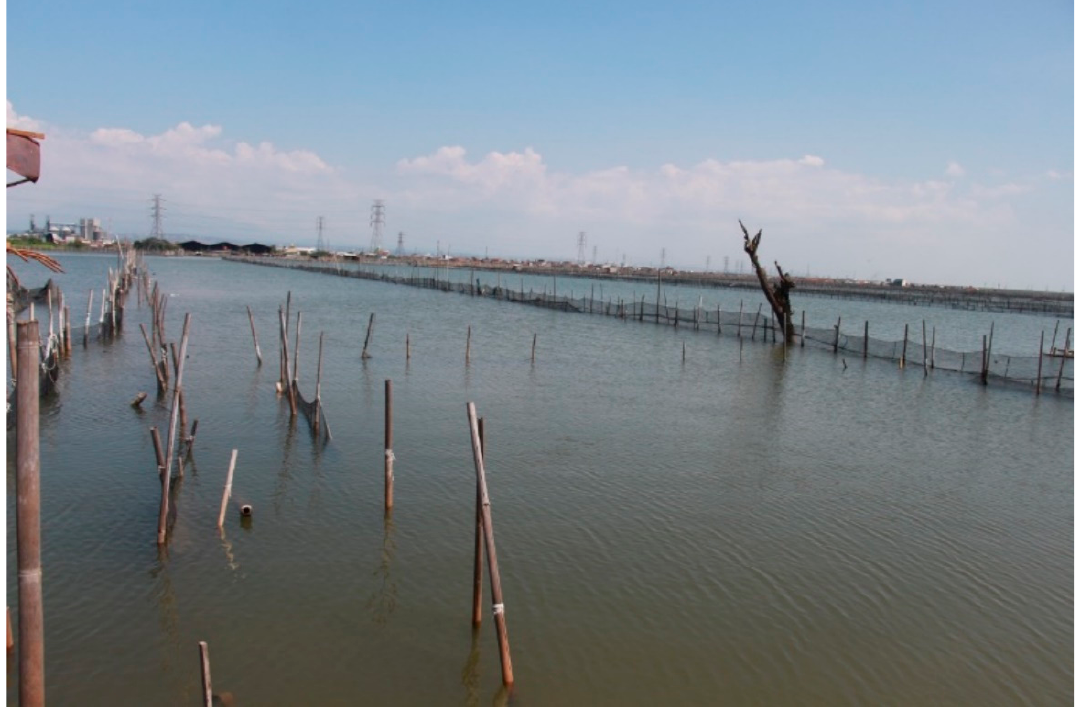
Figure 5. Second type of inundated land. Most of the land owners use this land for fishponds and clam breeding. The land owners use wooden stakes and fishnet to mark their land boundary. Source: field data collection.